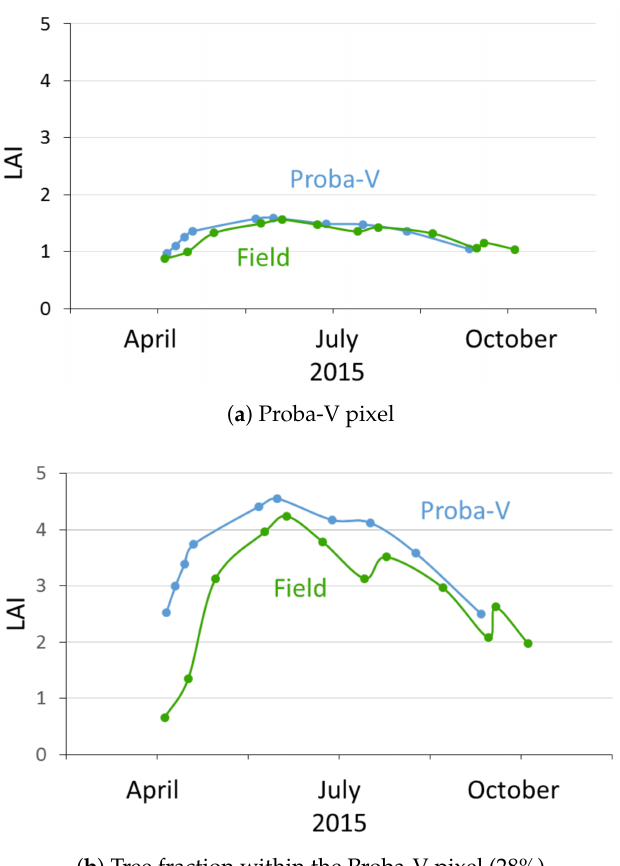
Figure 7. LAI dynamics of ( a ) the selected Proba-V pixel and ( b ) the tree fraction within the Proba-V pixel (28%) at the Vrije Universiteit Brussel (VUB) campus, Brussels,